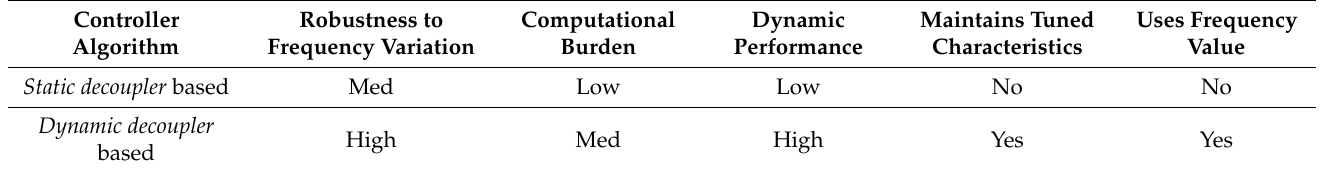
Table 3. Comparison of key features of static and dynamic decoupler based